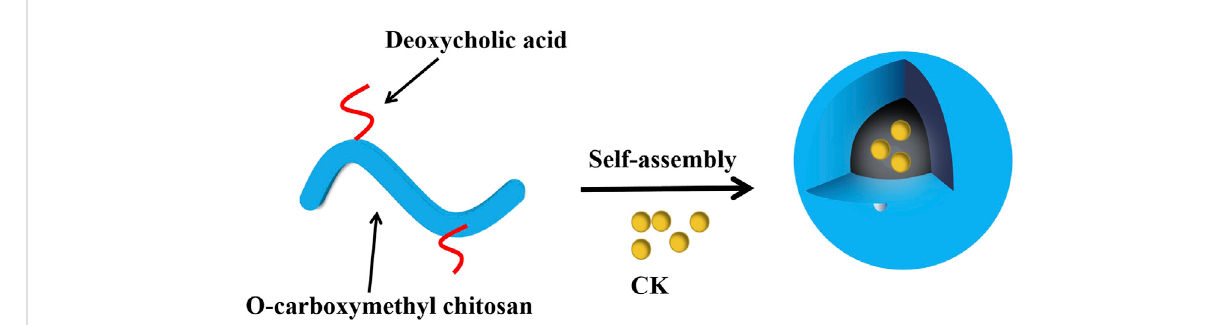
FIGURE 6 Self-assembly process of chitosan nanoparticles loaded with minor ginsenoside CK (Zhang et al., 2018).